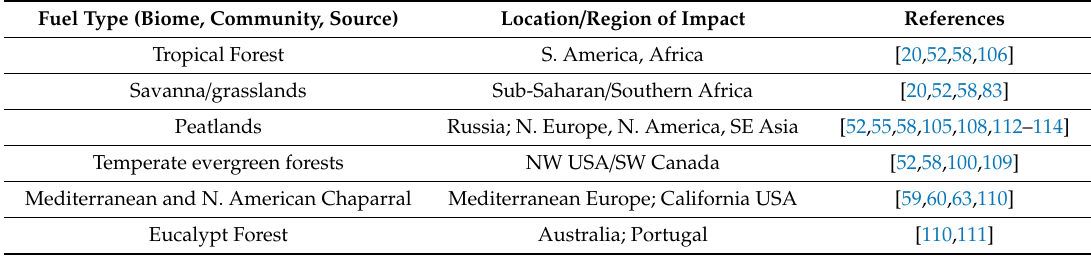
Table 2. Examples of wildland fuels whose emissions cause su ffi cient impacts to air quality and public health to merit priority consideration for biomass burning emission